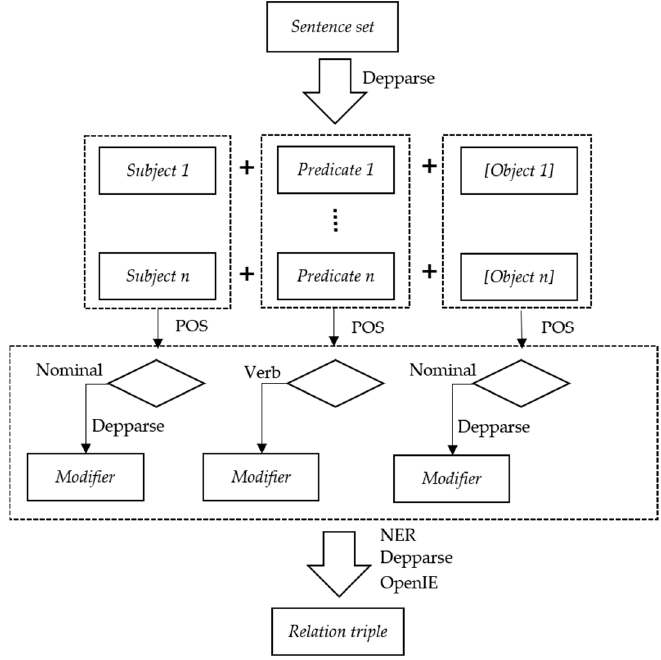
Figure 5. Overview of the relation triple extraction process